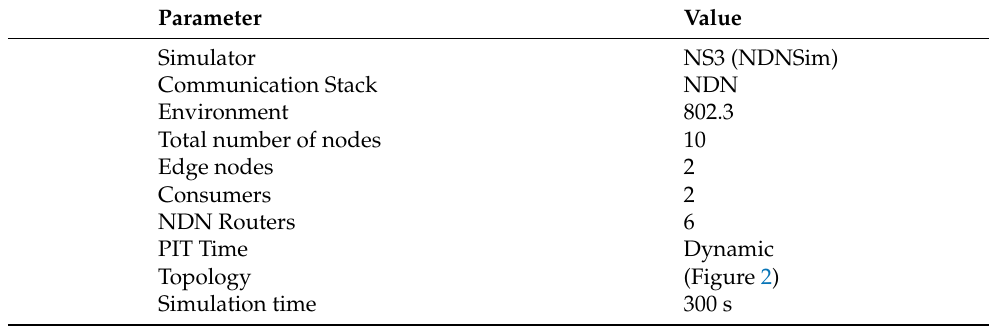
Table 1. Simulation